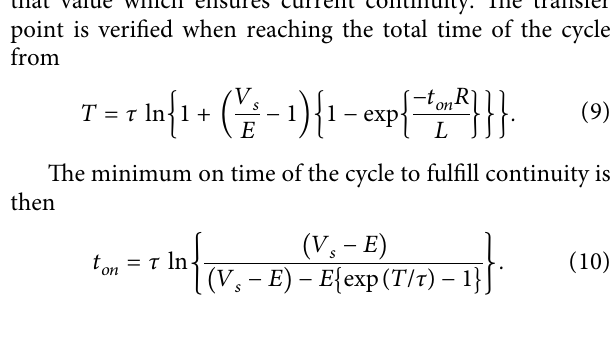
Figure 9: Variation of the BSC and minimum voltage with frequency at different load inductances. Table 1: Continuous current mode parameters. Drive